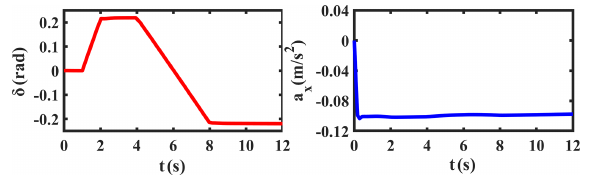
Figure 9. The obtained δ and a x under fishhook manoeuver test I.